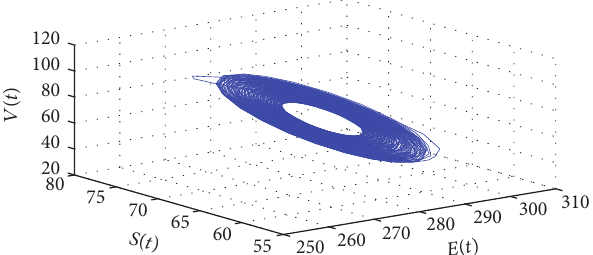
Figure 7: The projection of the phase portrait of system (69) in (𝑆,𝐸, 𝑉) -space with 𝜏